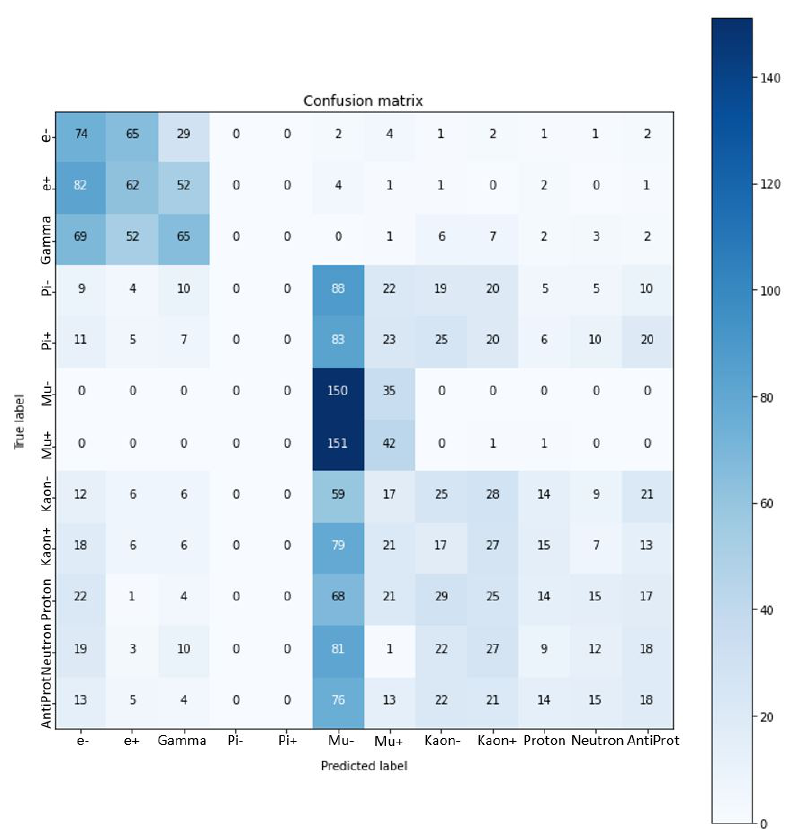
Figure 7. Confusion matrix: 12 particles after 2,400 samples.